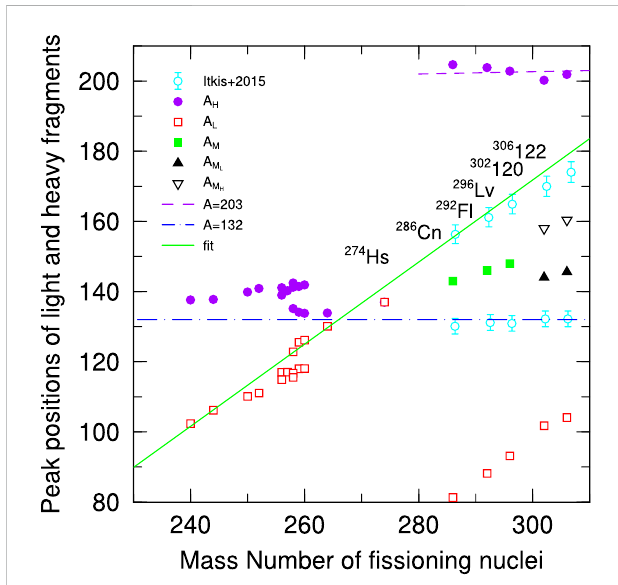
FIGURE 3 Averaged peak positions of light and heavy fragments as a function of a compound nuclear mass. Light blue symbols with error bars are experimental data measured by Itkis et al. The other symbols are our calculations. The subscripts of symbol legends, H, L, M, M H and M L , denote the heaviest peak, the lightest peak, the middle peak, the heavier middle peak, and the lighter middle peak in mass